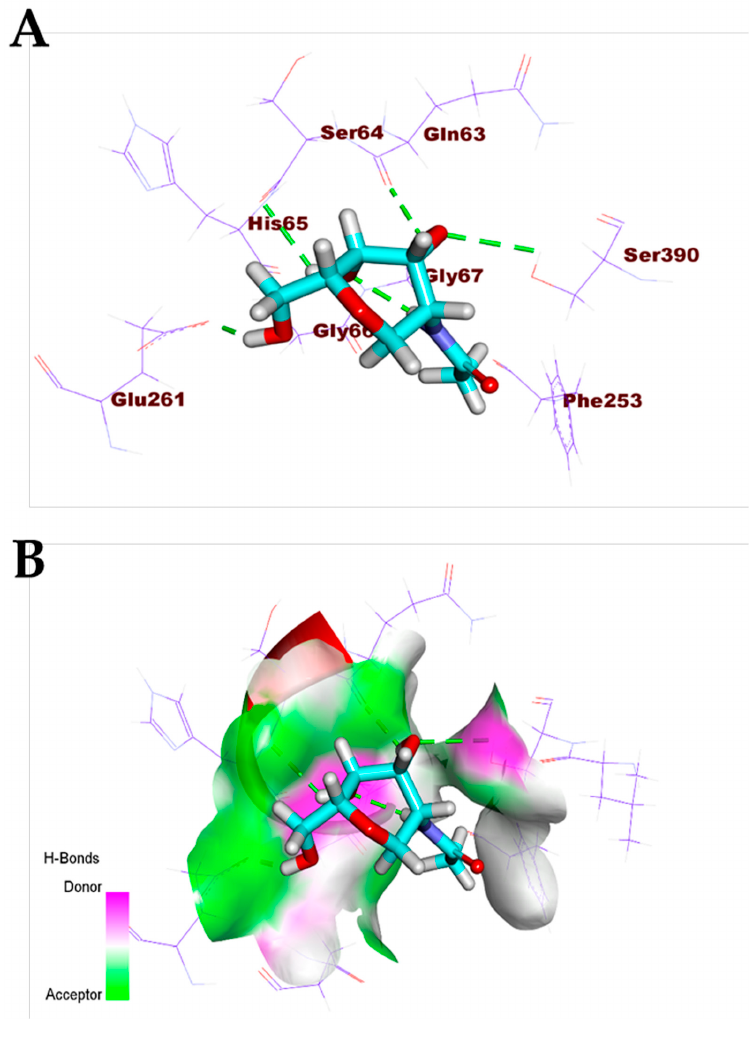
Figure 6. ( A ) Co-crystallized ligand (NAG)docked into the active site of COVID-19 membrane glycoprotein. ( B ) Mapping surface showing co-crystallized ligand (NAG) occupying the active pocket of COVID-19 membrane glycoprotein.